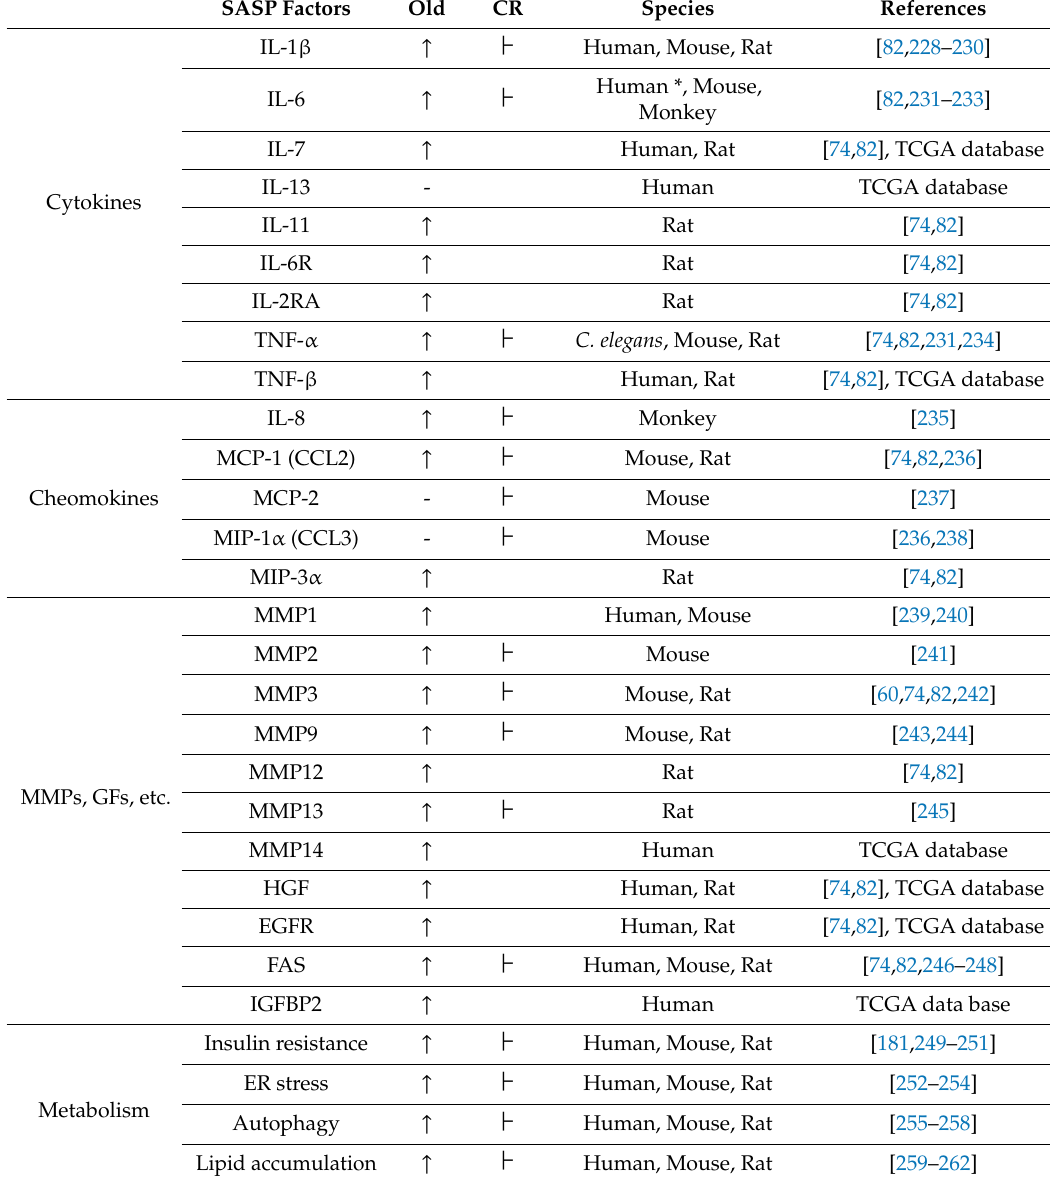
Table 1. Changes in parameters in